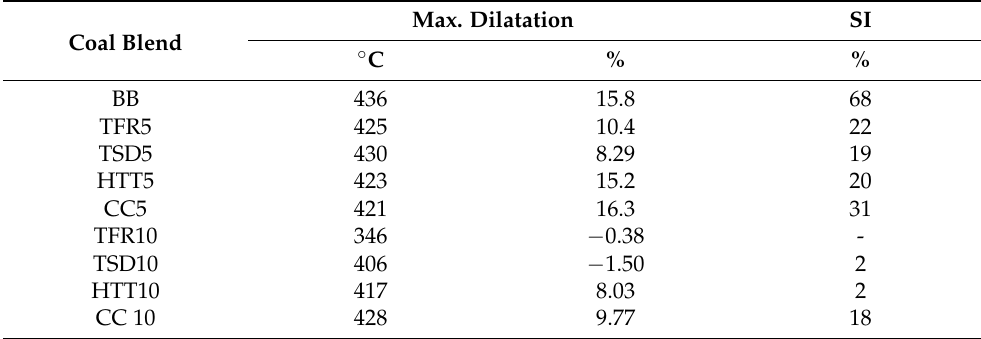
Table 7. Thermoplastic parameters for the basic coal blend, BB, and coal blends with the addition of bio-coals, deduced from optical dilatometer tests.